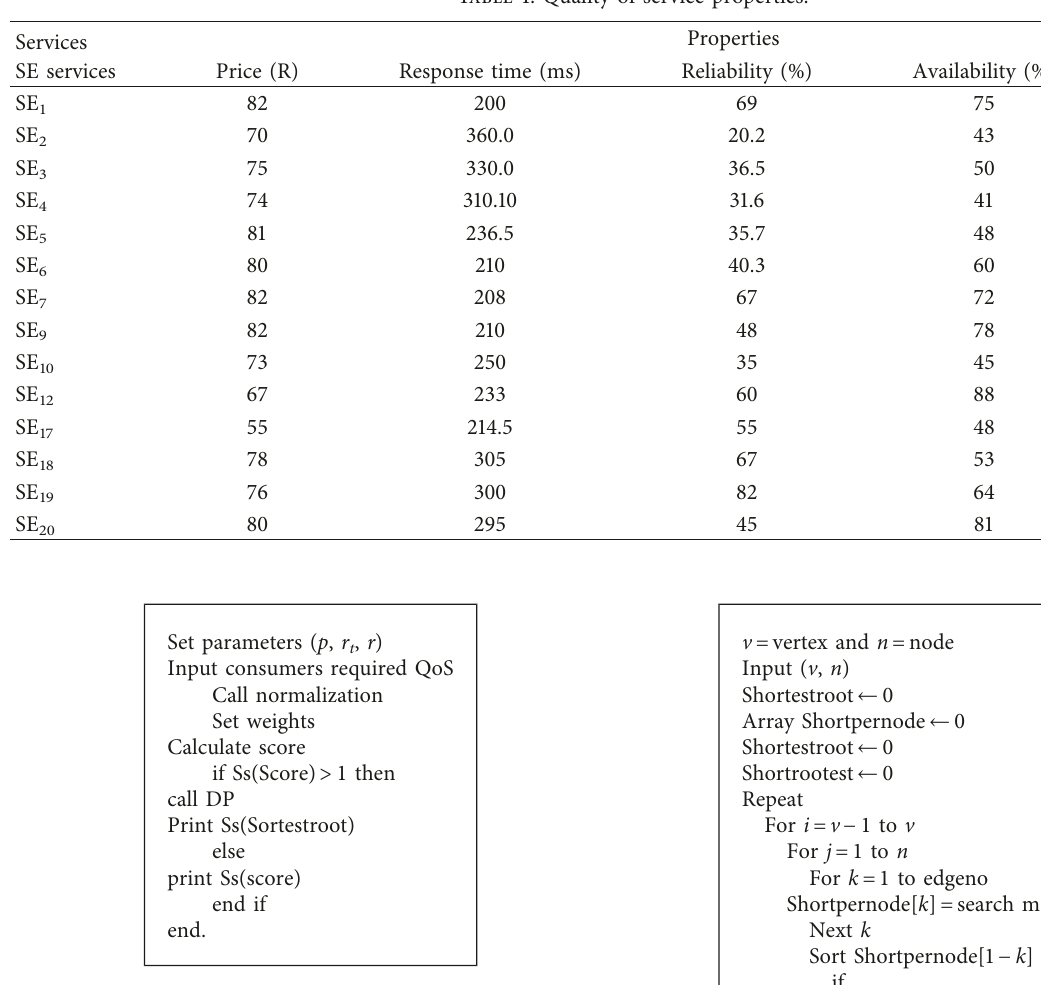
Table 1: Quality of service properties.